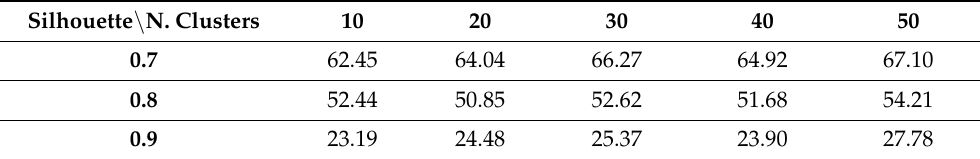
Table 14. Clustering performance in terms of silhouettes using the reduced dataset with PCA. Silhouette \ N. Clusters